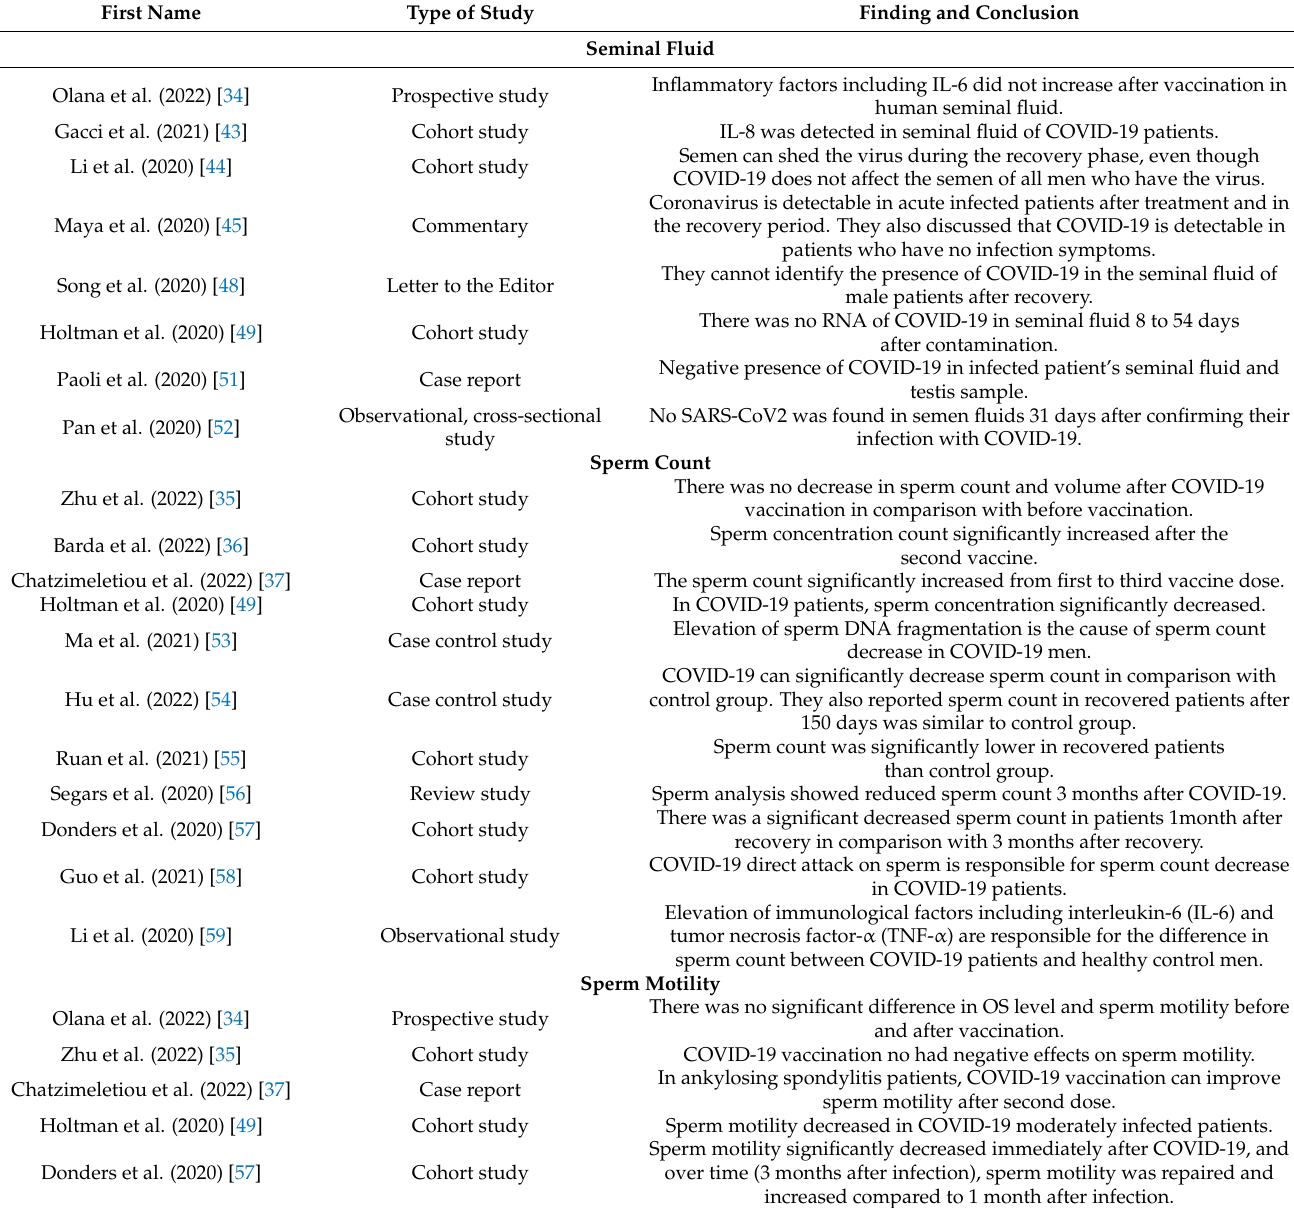
Table 1. COVID-19 vaccination and male reproductive potential. Summarization of some key studies of the effects of COVID-19 infection and vaccination on male fertility